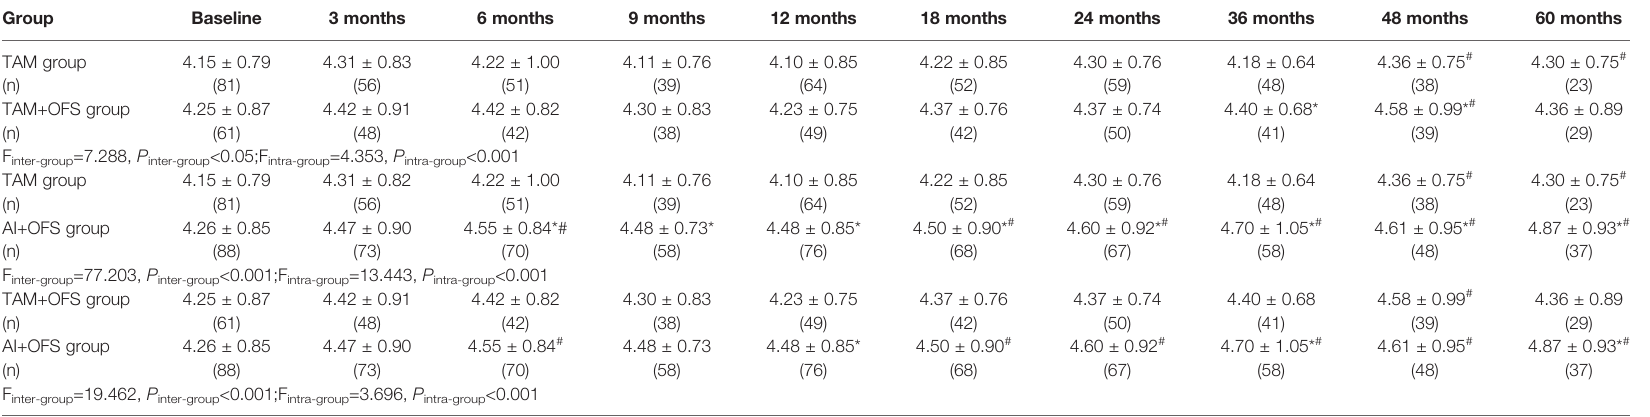
F inter-group =19.462, P inter-group <0.001;F intra-group =3.696, P intra-group <0.001 n represents patient number. *P value < 0.05, compared to the other group at the same time-point. # P value < 0.05, compared to the baseline at the same group.